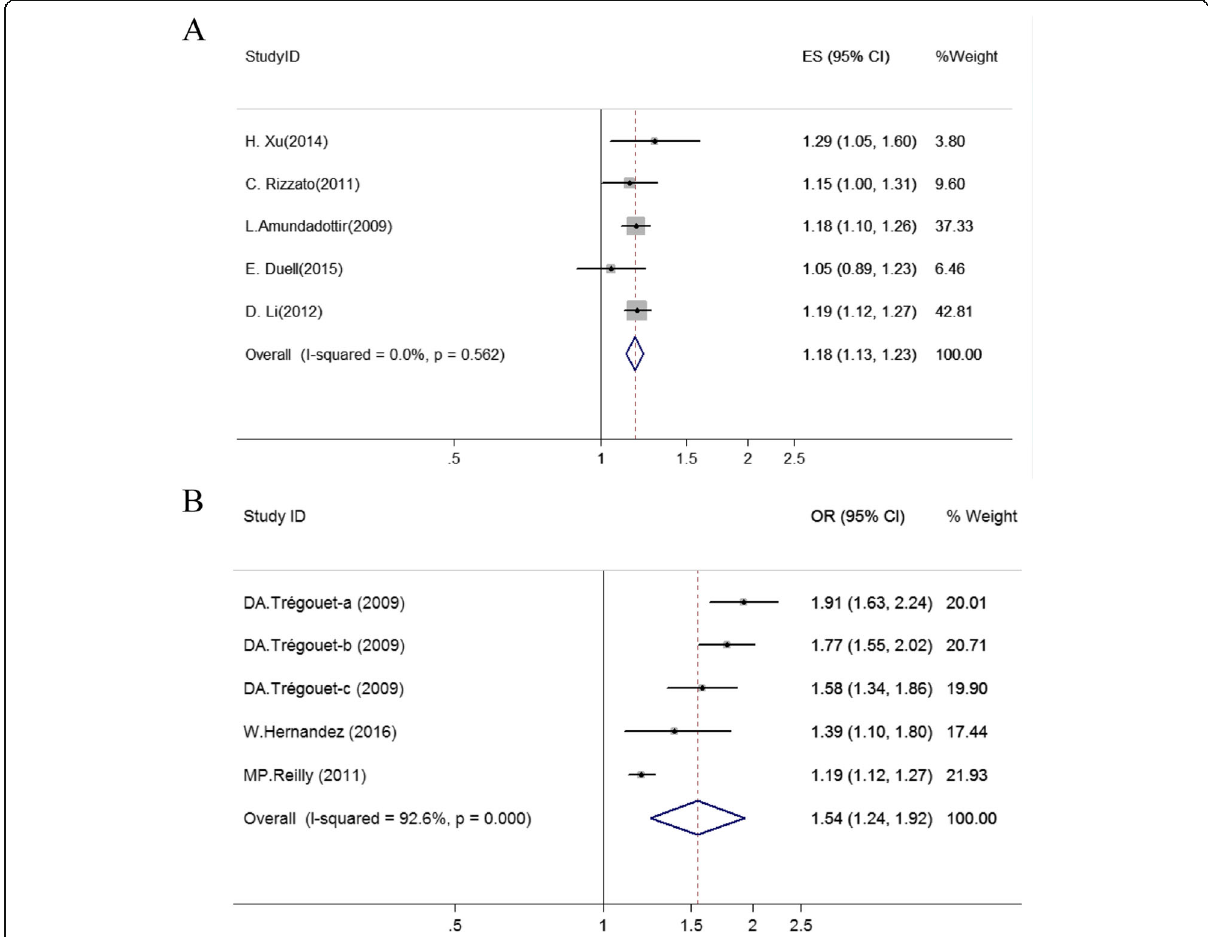
Fig. 3 Forest plot of the relationship between rs657152 polymorphisms and cancer ( a ) and cardiocerebrovascular disease ( b ) risk (allele model and random-effect model). The circle and horizontal lines correspond to OR and 95% CI and the area of the squares reflects the weight of individual studies included in the meta-analysis. The diamond represents the pooled ORs and 95% CI. The dotted red line represents the total OR